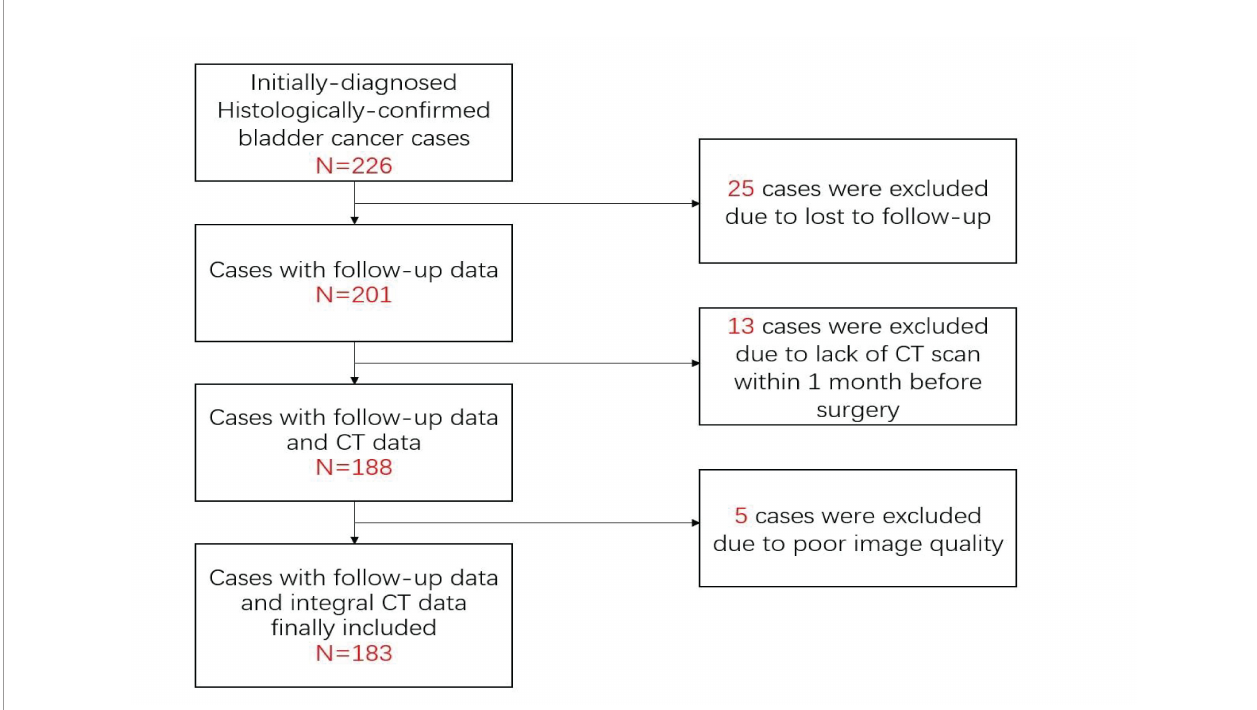
FIGURE 1 | Flowchart shows selection criteria for the 183 patients in the study